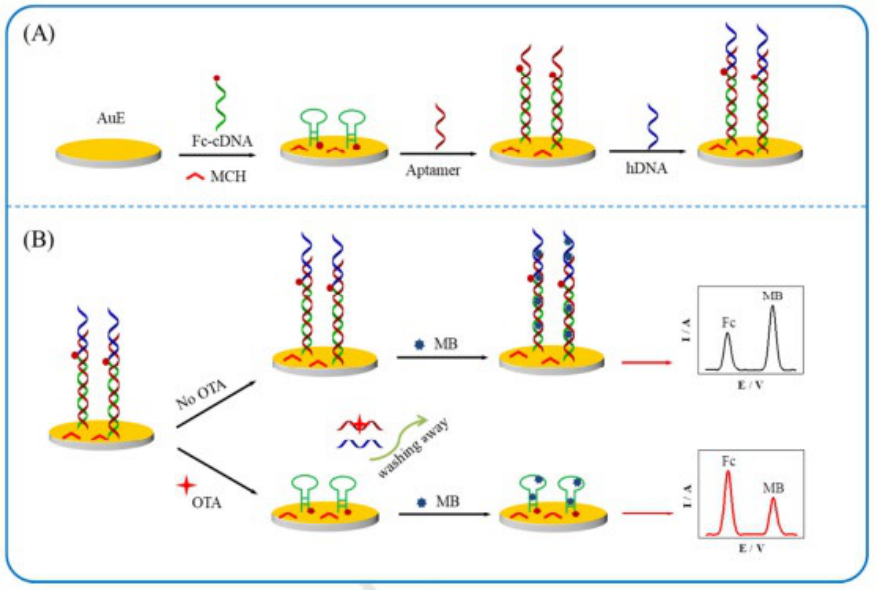
Figure 4. Schematic representation of the fabrication and detection process of the aptasensor. ( A ) design of aptasensor by stepwise addition of Fc-cDNA, OTA aptamer and hDNA on Au electrode ( B ) special affinity for OTA caused dissociation of aptamer and formation of hairpin structure. Reproduced from [40]. Copyright 2020 Elsevier. hDNA: helper DNA, dsDNA: double-stranded DNA, cDNA: complementary DNA, MB: methylene blue; Fc-DNA: Ferrocene-labeled complementary DNA. Using direct and indirect competitive methods, an automatic flow-based electrochemi- cal aptasensor (5 (cid:48) -GAT-CGG-GTG-TGG-GTG-GCG-TAA-AGG-GAGCAT-CGG-ACA-3 (cid:48)